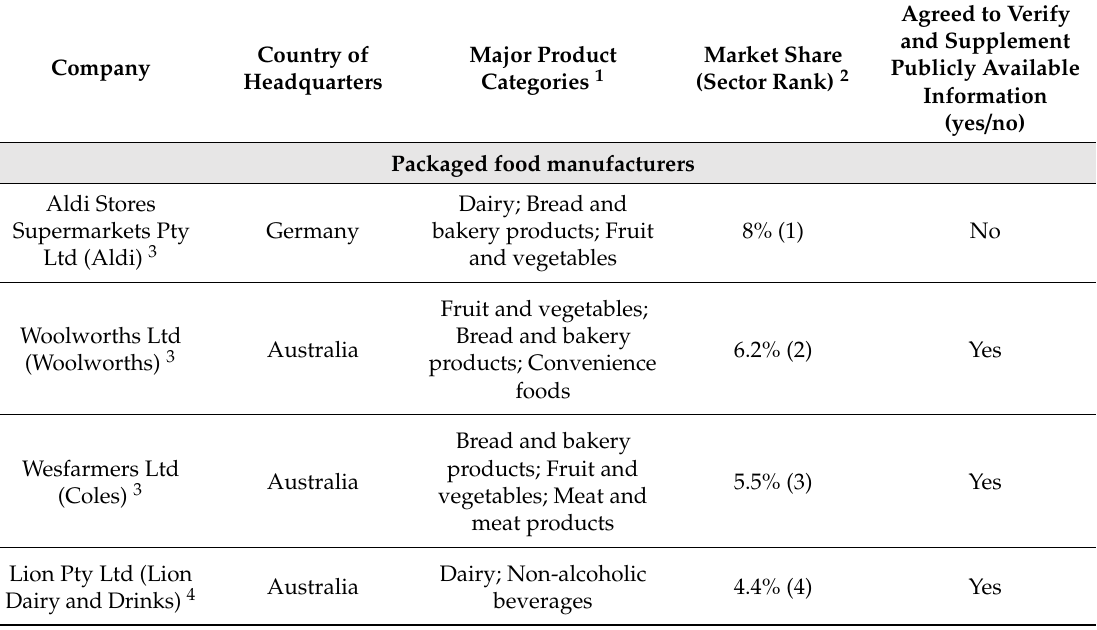
Table 1. Companies selected for inclusion in the BIA-Obesity Australia 2018 assessment.